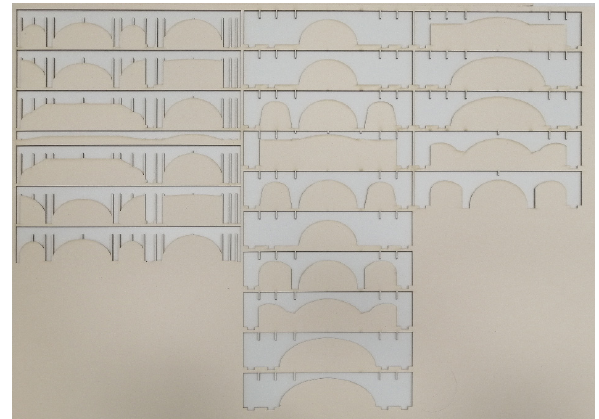
Figure 10. Waste material of the physical model of Palazzo Mazzonis atrium. Digital prototyping: F. Ronco.